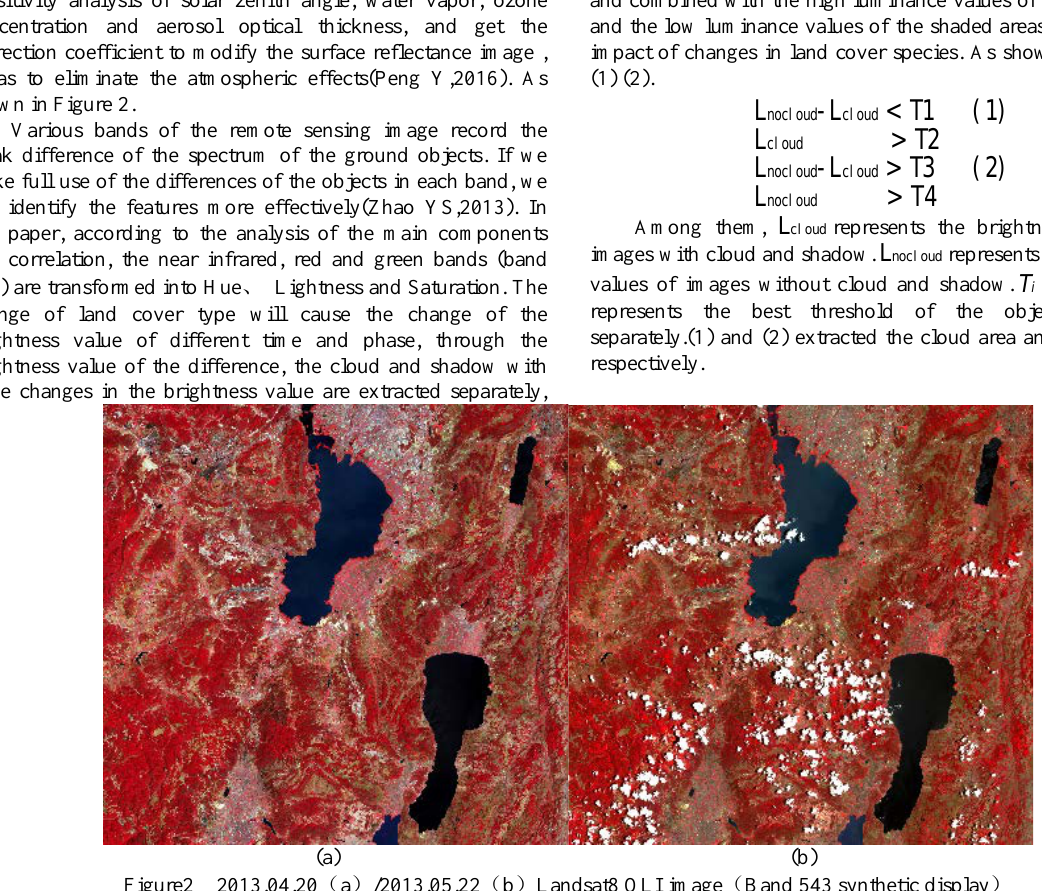
Figure2 2013.04.20 （ a ） /2013.05.22 （ b ） Landsat8 OLI image （ Band 543 synthetic display ）